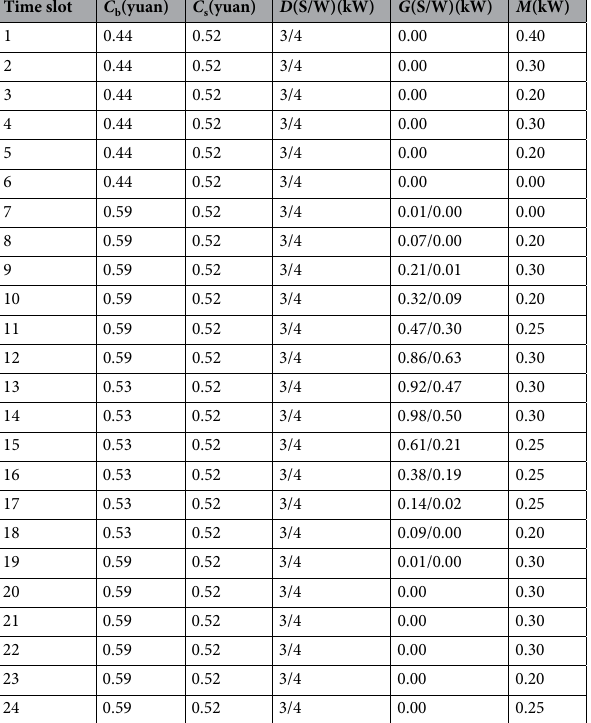
Table 4. Time-related information.